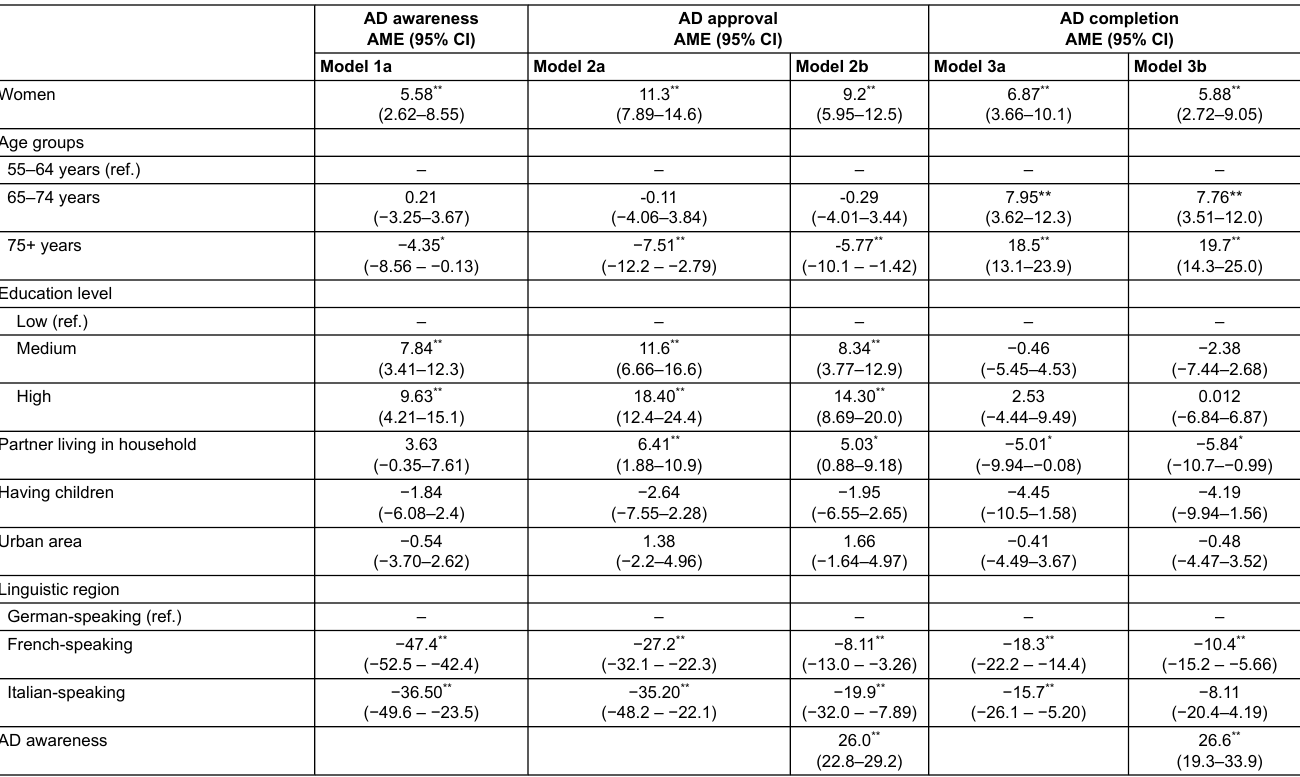
Table 2: Average marginal effects (AMEs) of views of advance directives (ADs) by sociodemographic characteristics and AD awareness, adults aged 55+ in Switzerland (n = 2085), SHARE